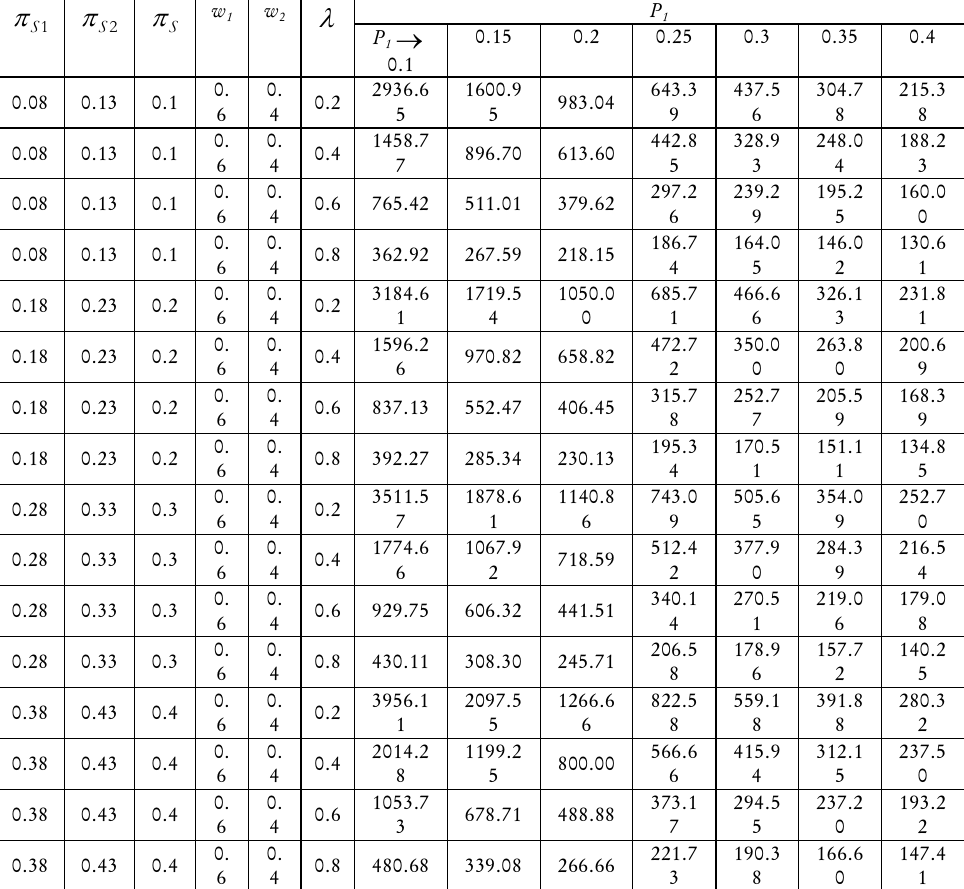
π ∗ with respect to Kim and Warde’s (2005) c π estimator ˆ kw